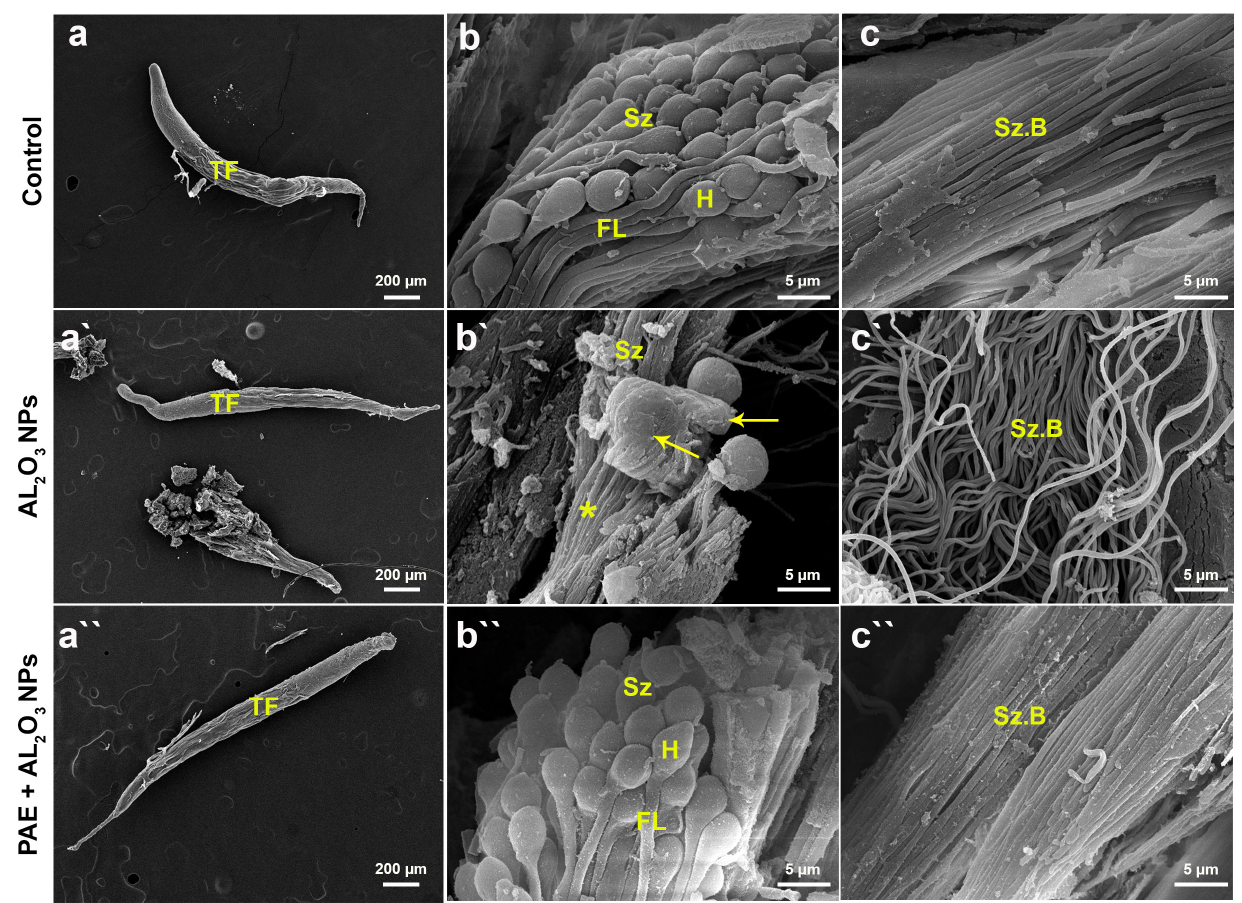
Figure 11. Scanning electron micrographs of the testicular tissues of L. migratoria using SEM after Figure 11. This is a figure. Schemes follow the same formatting. If there are multiple panels, they Al 2 O 3 NPs injection with or without PAE treatment. The typical structure of the testicular should be listed as: ( a ) Description of what is contained in the first panel. ( b ) Description of what is contained in the second panel. Figures should be placed in the main text near to the first time they are cited. A caption on a single line should be centered.